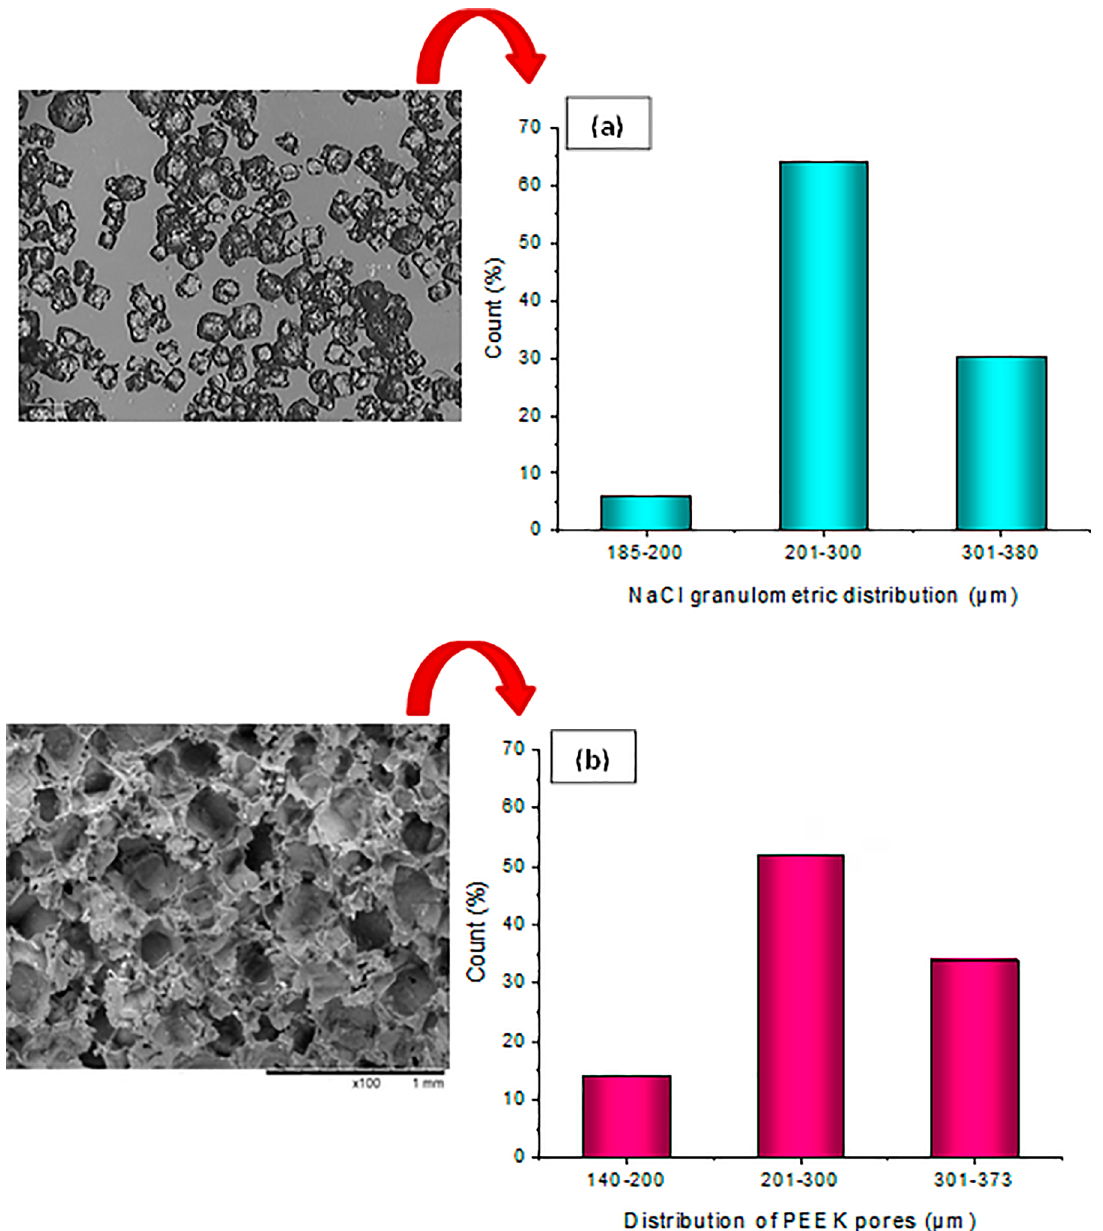
Figure 3. Histograms of NaCl granulometric distribution (a) and distribution of PEEK porous (b) measured with ImageJ